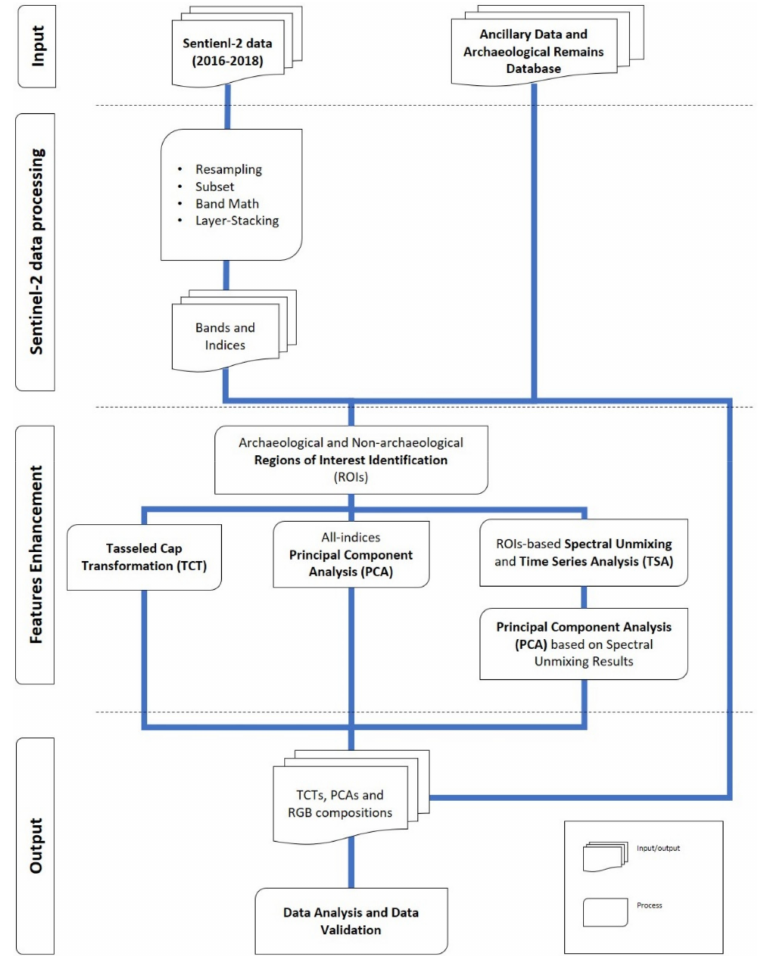
Figure 2. Flowchart of the